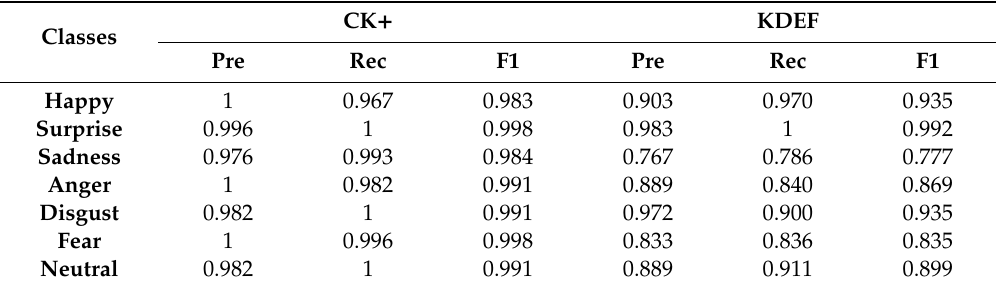
Table 5. Pre (Precision), Rec (Recall), F1 (F1 Score) shown for dataset CK + , and KDEF. Values are shown for the Support Vector Machine (SVM) classifier for seven